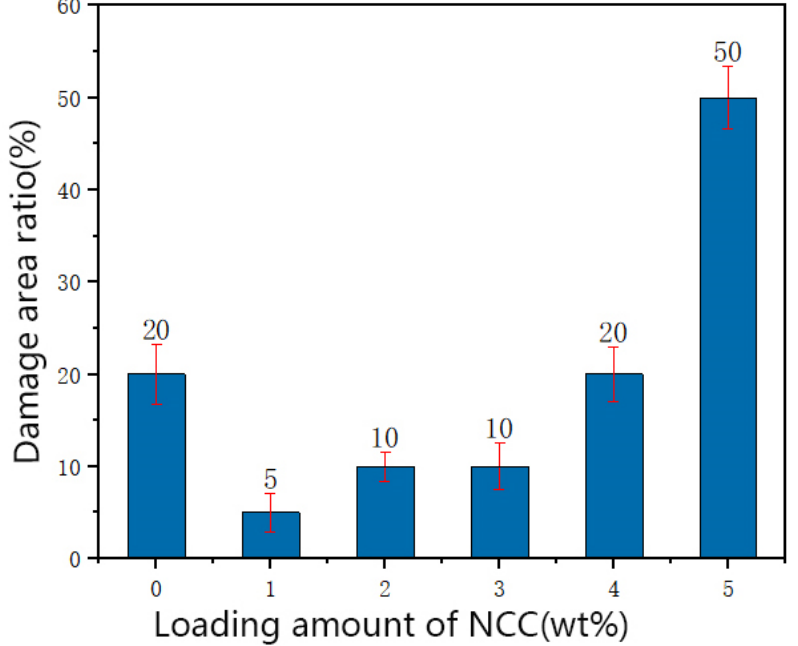
Figure 1. The results of scribe testing with different loadings of nanocellulose crystalline (NCC).